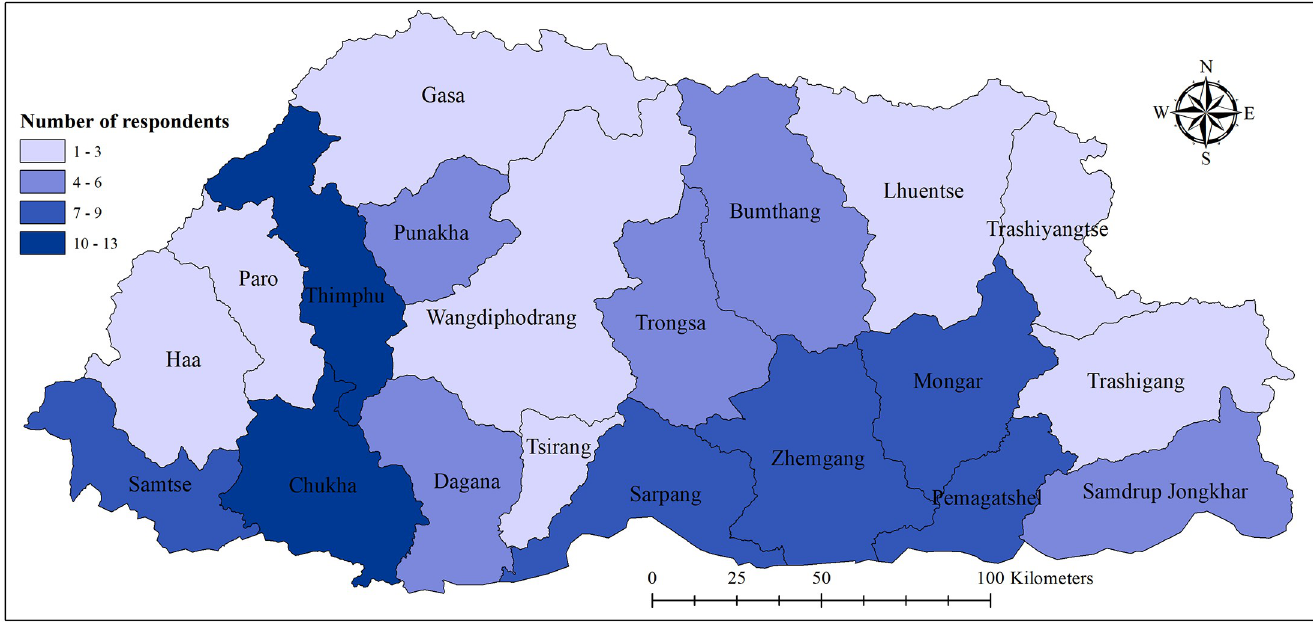
Fig 3. District-wise number of respondents included in the study, Bhutan, 2019–2020.